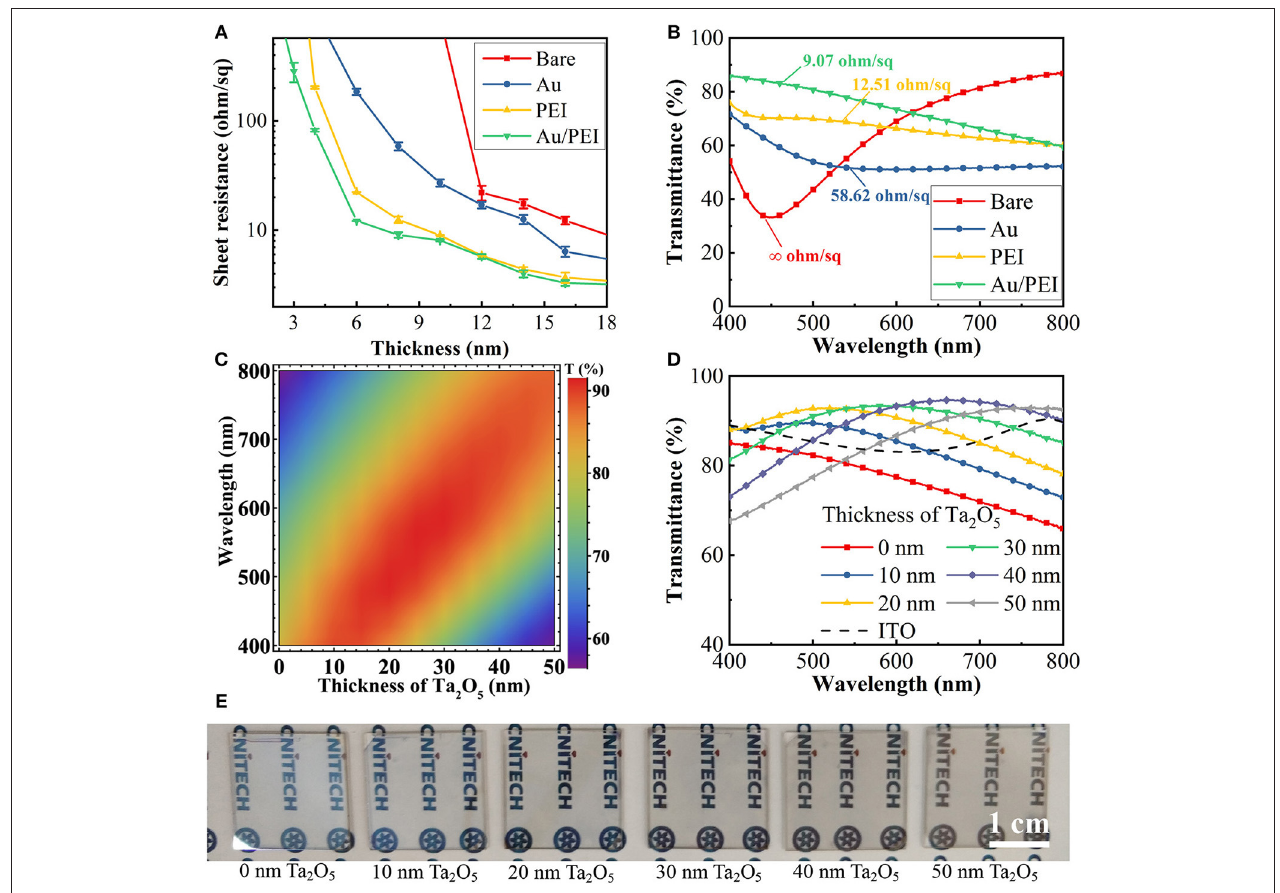
FIGURE 3 | (A) Sheet resistance of Ag films on different NISLs as a function of Ag thickness. (B) Transmission spectra of 8-nm-thick Ag film on different NISLs. (C) Calculated transmittance of APAT film as a function of wavelength and thickness of Ta 2 O 5 layers. (D) Transmittance spectra and (E) optical photographs of APAT films with various Ta 2 O 5 thicknesses. The transmittance spectra of conventional ITO (black dashed line) is also shown for comparison.